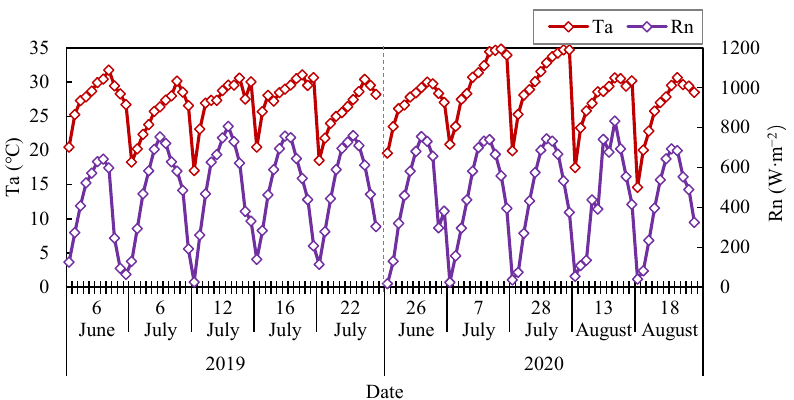
Figure Figure 3. The diurnal variations of air temperature ( T a ) and net radiation ( R n ) in the investigation days.